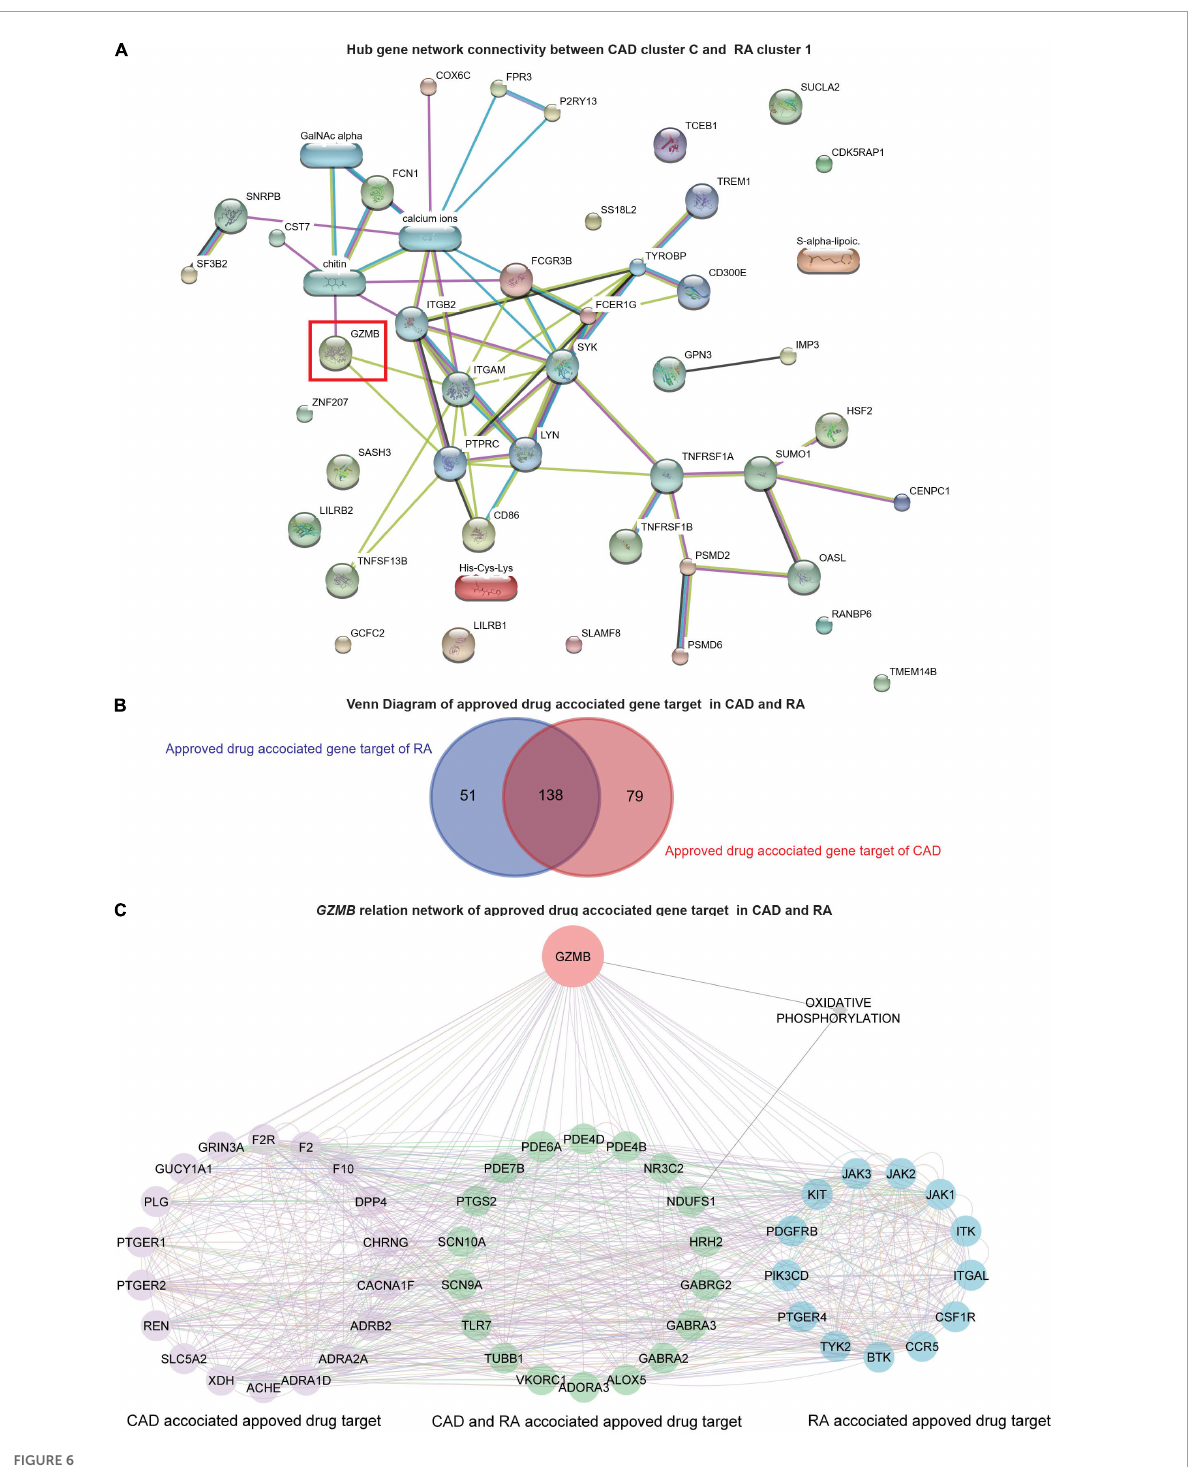
FIGURE6 Network analysis and GZMB -related drugs targets. (A) The network analysis for the hub genes from cluster C of GSE59867 (CAD) and cluster 1 of GSE93272 (RA) hub genes using the STITCH database. The large nodes represent the known protein structures, wherein the small nodes represent the unknown protein structures. The identified subpopulation-differentiation marker, GZMB, was marked within a red box. The colors of the nodes and edges were predefined by STITCH. (B) Using the Open Target platform, the Venn diagram for the extracted drug-target genes (DTGs) of CAD and RA (blue). (C) Network-level association of GZMB and the related DTGs. The gene GZMB , the ReDisX identified gene of interest, the CAD-associated approved drug targets (purple), the approved drug targets for CAD and RA (green), and the approved drug targets for RA (blue) share a direct correlation. GeneMANIA predefined the colors of the